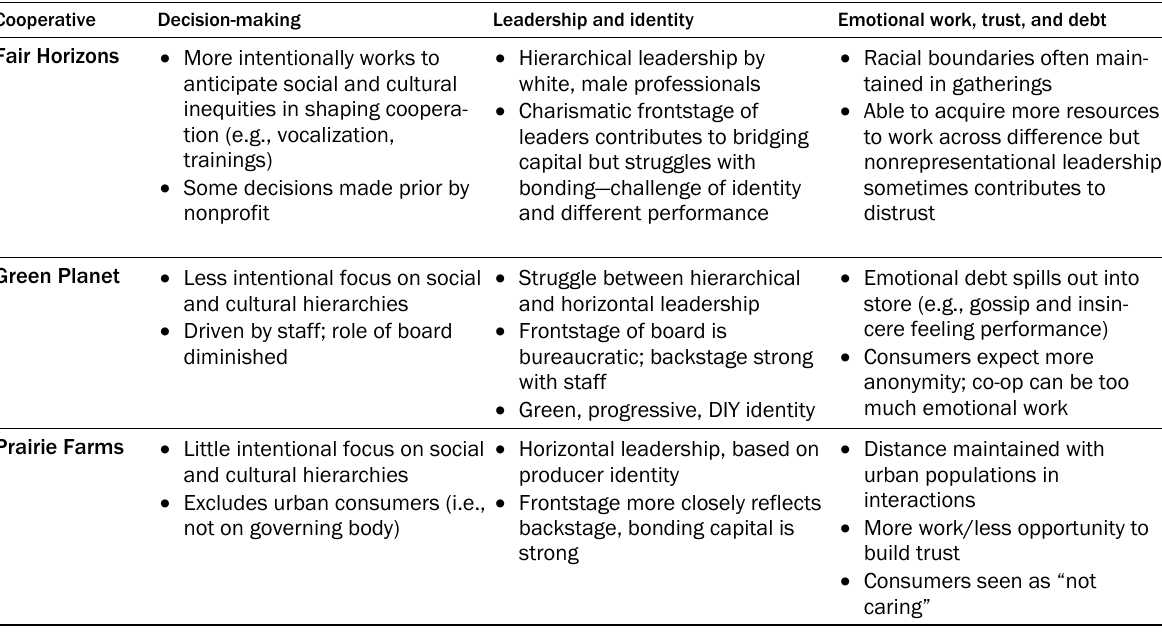
Table 3: Cooperative Actions of Three Cooperative Cases